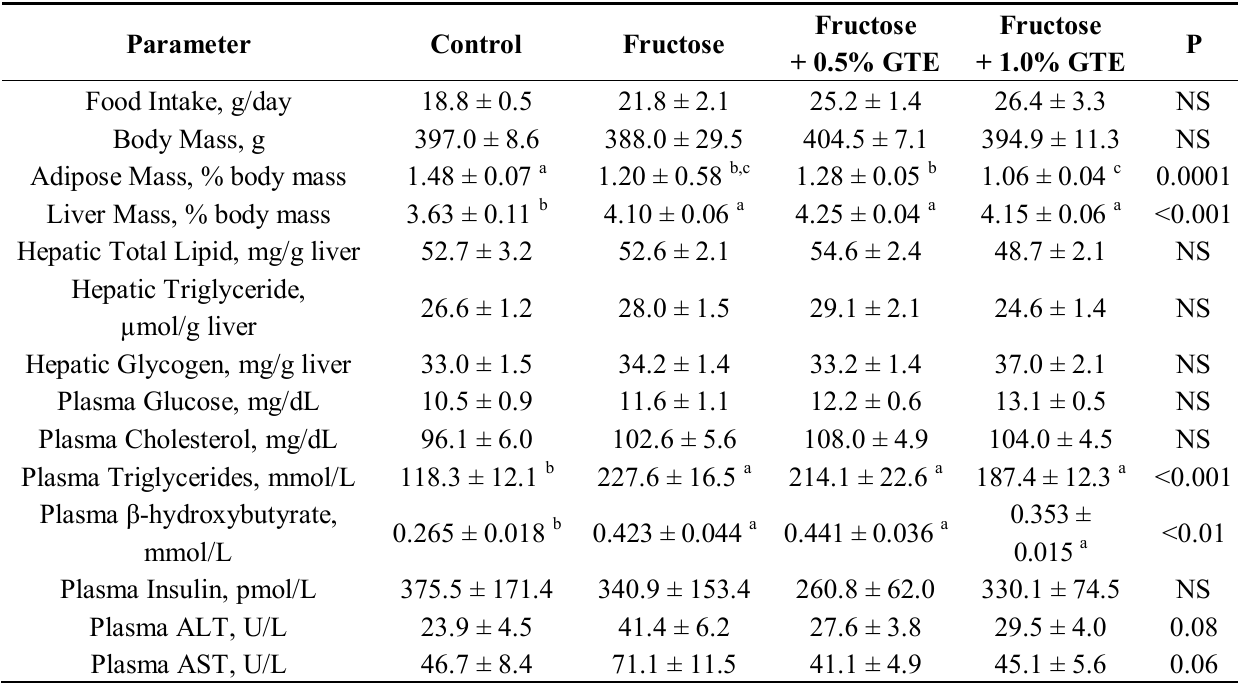
Table 2. Body composition and clinical chemistries 1